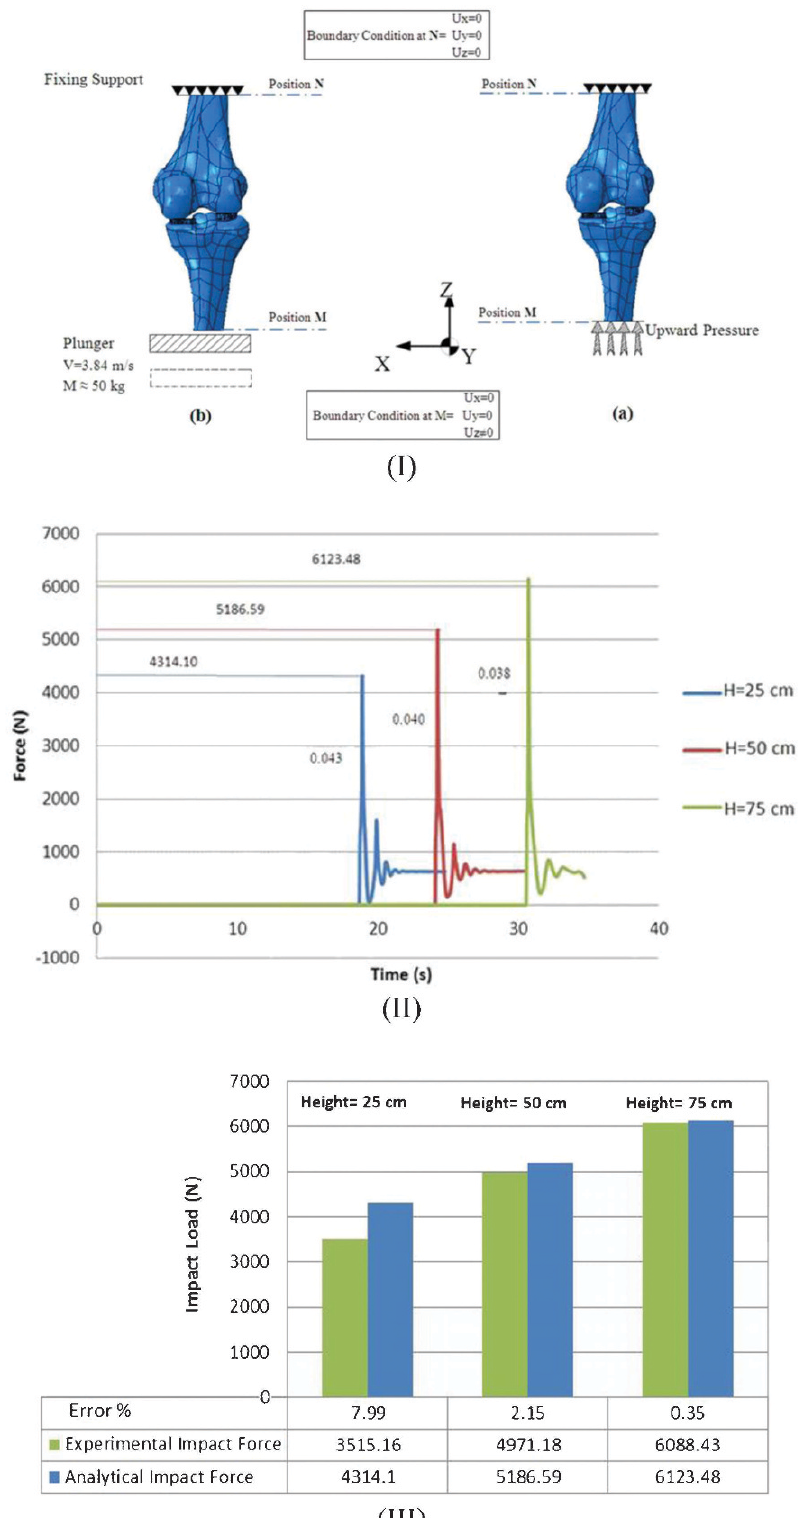
Knee stress in full extension landing Makinejad MD et